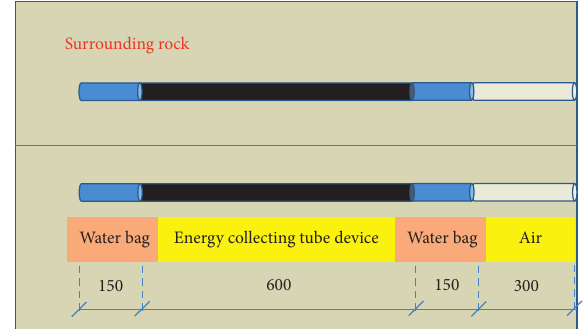
Figure 11: Schematic diagram of structure without gun clay-poly